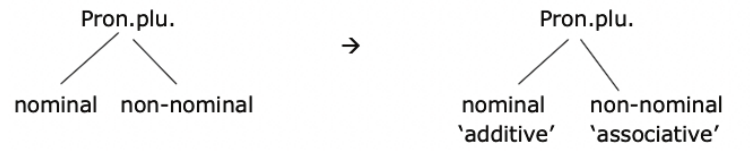
Figure 6: Motivating variants by meaning (pronouns across languages) This semantic distinction makes sense of the occurrence of one type of language – where the third-person plural pronoun is nominally marked but the other persons are not – and of the non-existence of a logically possible system where first- and second-person plurals are nominally marked but the third person is